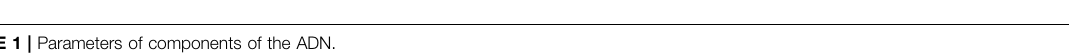
TABLE 1 | Parameters of components of the